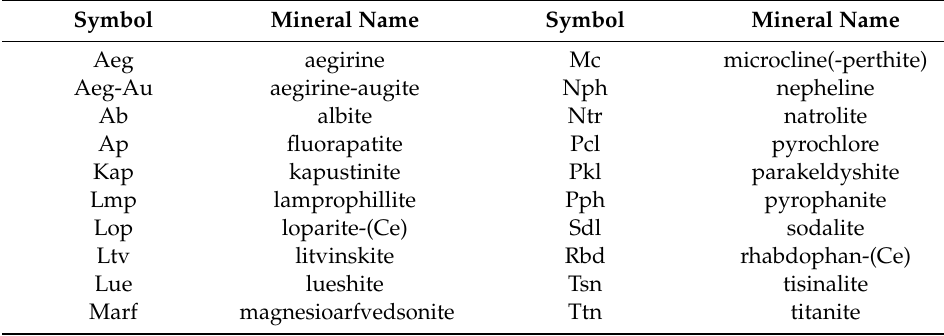
Table 1. Mineral